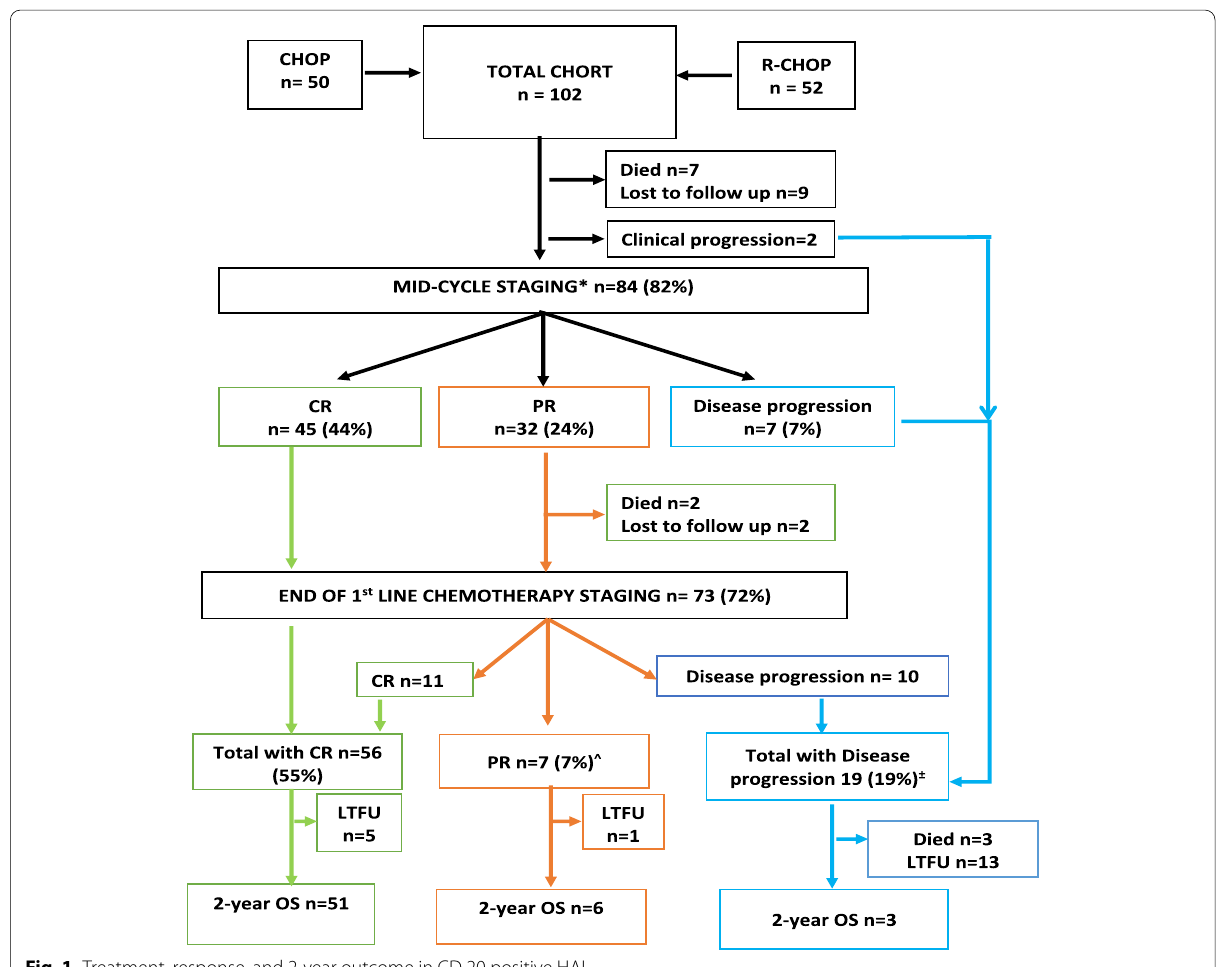
Fig. 1 Treatment, response, and 2‑year outcome in CD 20 positive HAL Abbreviations: CHOP cyclophosphamide, doxorubicin, vincristine, prednisone, R rituximab, CR complete response, PR partial response, LTFU lost to follow up, OS overall survival. *10 patients had CTscans and 74 patients had PET‑CT scans at mid‑cycle re‑staging. ^ 6 patients received 2